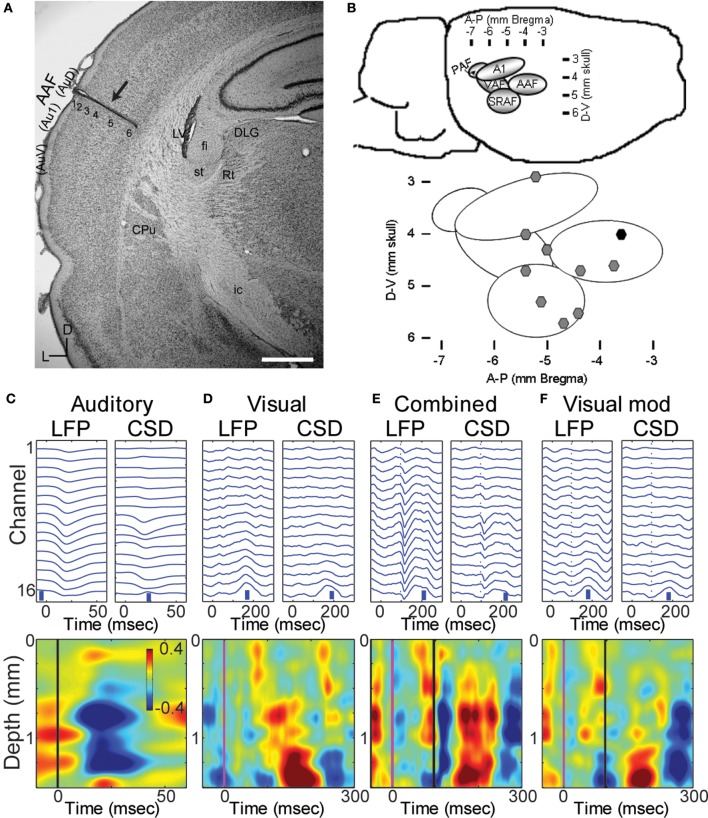
Multichannel recordings of sensory responses from auditory cortex in vivo. (A) Photomicrograph of a section through auditory cortex of a chronically implanted rat. The electrode trace can be clearly seen in auditory cortex (arrow). Scale bar in lower right is 1 mm. (B) Location of implanted probes: a map with coordinates of the auditory areas on the rat's brain (top) and the location of the implanted electrodes used in the manuscript on the map (black symbol: probe in A). (C–F) LFPs and derived CSD traces (top row) and CSD contour plots (bottom row) in response to a 50 ms tone burst at best frequency (13.4 kHz, 40 dB SPL; C; tone onset at time zero), a 1 ms LED flash (D; flash onset at time 0), combined stimulation (E) of the LED flash (at time 0) and best-frequency tone (at 96 ms), and the calculated visual modulation of the auditory response (F; difference between the combined and auditory responses). In CSD contour plots, sinks are indicated by blue and cool colors. Units for color bars are μA/mm3 throughout the manuscript. Scale bars (vertical blue bars) in top row of (C–F): 0.1 mV and 1 μA/mm3. Vertical lines in bottom row of (C) mark stimulus onsets: black, auditory; magenta, visual. Most anatomical terminology adopted from Polley et al. (2007), except “Au1,” “AuD,” and “AuV,” from Paxinos and Watson (2007). Cortical parcellation scheme in (B) adapted from Polley et al. (2007). Abbreviations: Au1, primary auditory cortex; AuV, secondary (ventral) auditory cortex; AuD, secondary (dorsal) auditory cortex; CPu, caudate putamen; LV, lateral ventricle; st, stria terminalis; fi, fimbria (hippocampus); Rt, reticular thalamic nucleus; ic, internal capsule; DLG, dorsal lateral geniculate nucleus; AAF, anterior auditory field; PAF, posterior auditory field; VAF, ventral auditory field; SRAF, suprarhinal auditory field.